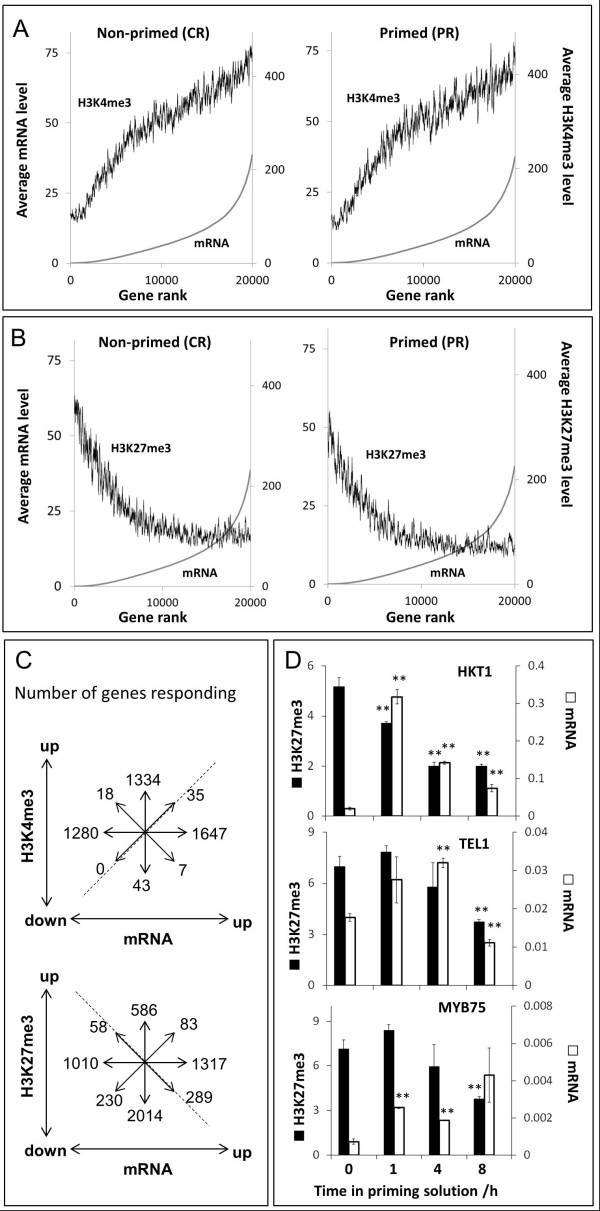
Relationship between histone methylation and mRNA levels during and after priming. (A, B) Genes on the x-axis were ranked according to mRNA levels determined by RNA-Seq. The mRNA profiles shown as smooth lines were generated from plotting for each gene on the x-axis the average mRNA values (right y-axis) over the neighboring genes with ranks of +/-100. Average values of histone modification levels (A: H3K4me3, B: H3K27me3) were plotted for the same genes (left y-axis). Relationships for non-primed root samples (CR) are shown in the graphs on the left, those for primed root samples (PR) are shown in the graphs on the right. (C) Numbers of genes that show an increase (up) or decrease (down) of mRNA level (x-axis) or histone modification level (y-axis) in response to the priming treatment (primed compared to non-primed roots). Note that the majority of changes observed immediately after the priming treatment do not show the expected positive (H3K4me3) or negative (H3K27me3) correlation between mRNA and histone modification (dashed lines). (D) Short-term kinetics of changes of mRNA and H3K27me3 levels in three genes (HKT1, TEL1, and MYB75) during the priming treatment. Relative enrichment of H3K27me3 (black bars) and mRNA levels (open bars) of selected genes in roots of A. thaliana seedlings were determined by qPCR over a time course of the first 8 h (x-axis) of the priming treatment (50 mM NaCl). H3K27me3 enrichment (left y-axis) was normalized to ChIP input and to a reference region in At5g56920. mRNA levels (right y-axis) were normalized to reference gene RpII. Bars show means ± SE of four pairwise ratios of two technical replicates of qPCR carried out with pooled root material from approximately 50 plants per time point. Significant differences to time point 0 are indicated with * for P <0.01.